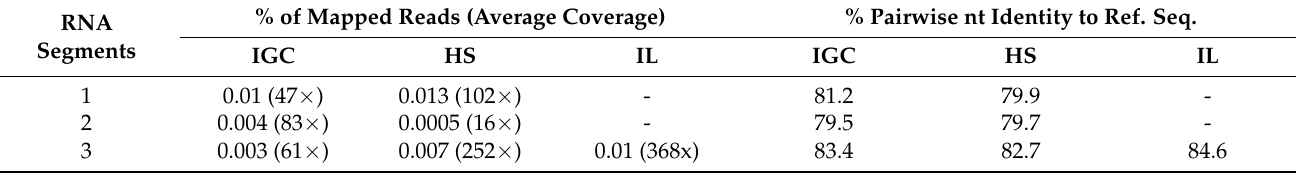
Table 3. The percentage (%) and average coverage of mapped reads to each RNA segment of BlMaV obtained from virome of cultivated V. corymbosum from Island Grove and wild V. corymbosum from High Springs and Interlachen, and the percentage of pairwise nt identity between each RNA to the corresponding reference sequences. Adapted from [5]. RNA